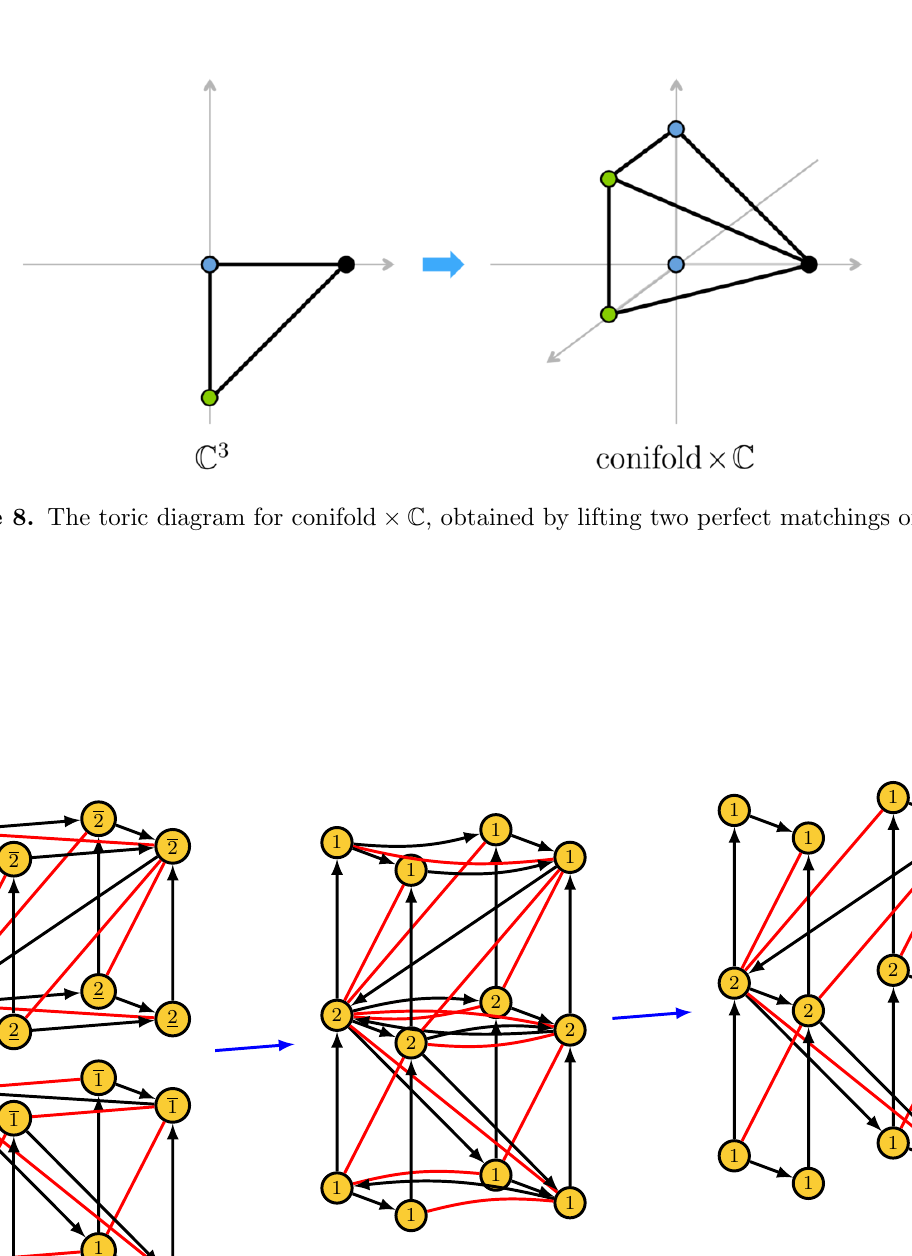
C using two C 3 quiver blocks (cid:2)